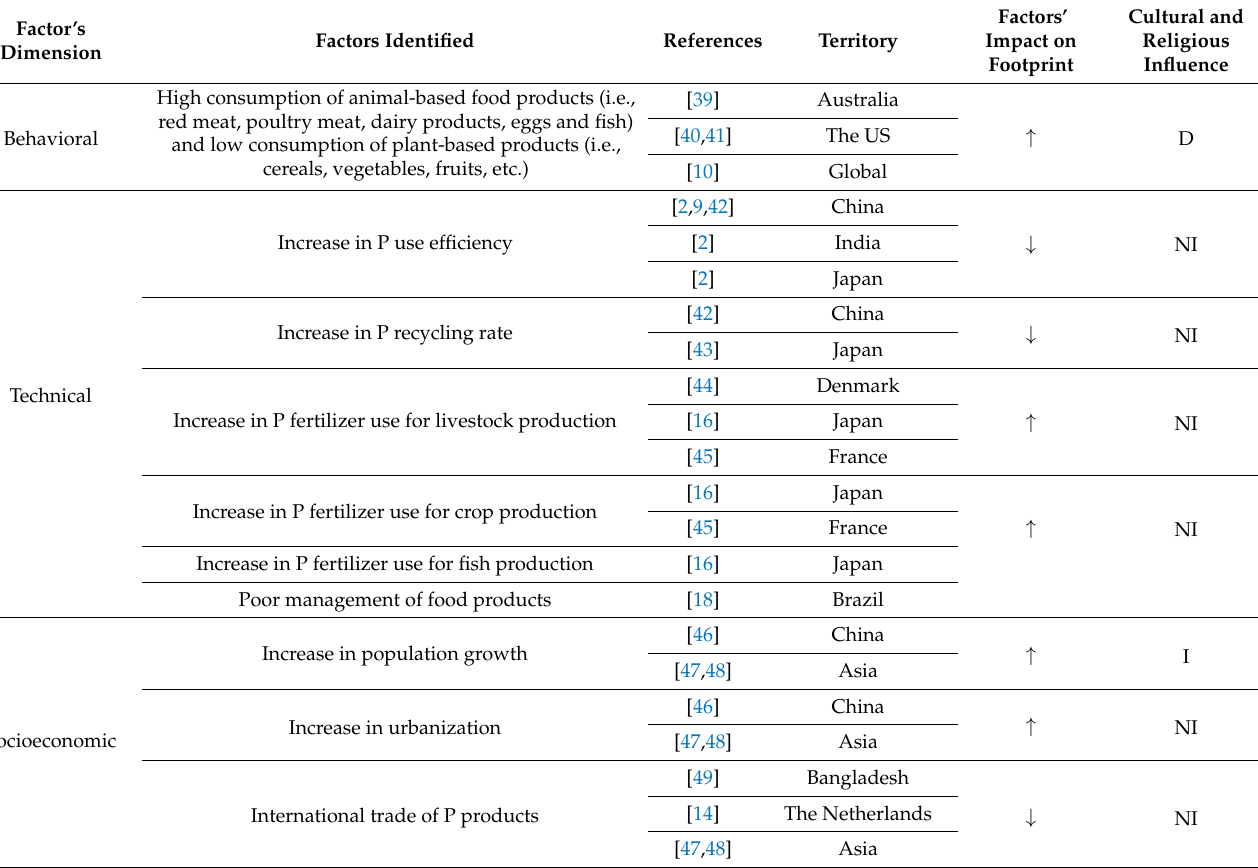
Table 4. Factors affecting food phosphorus footprint with possible cultural and religious